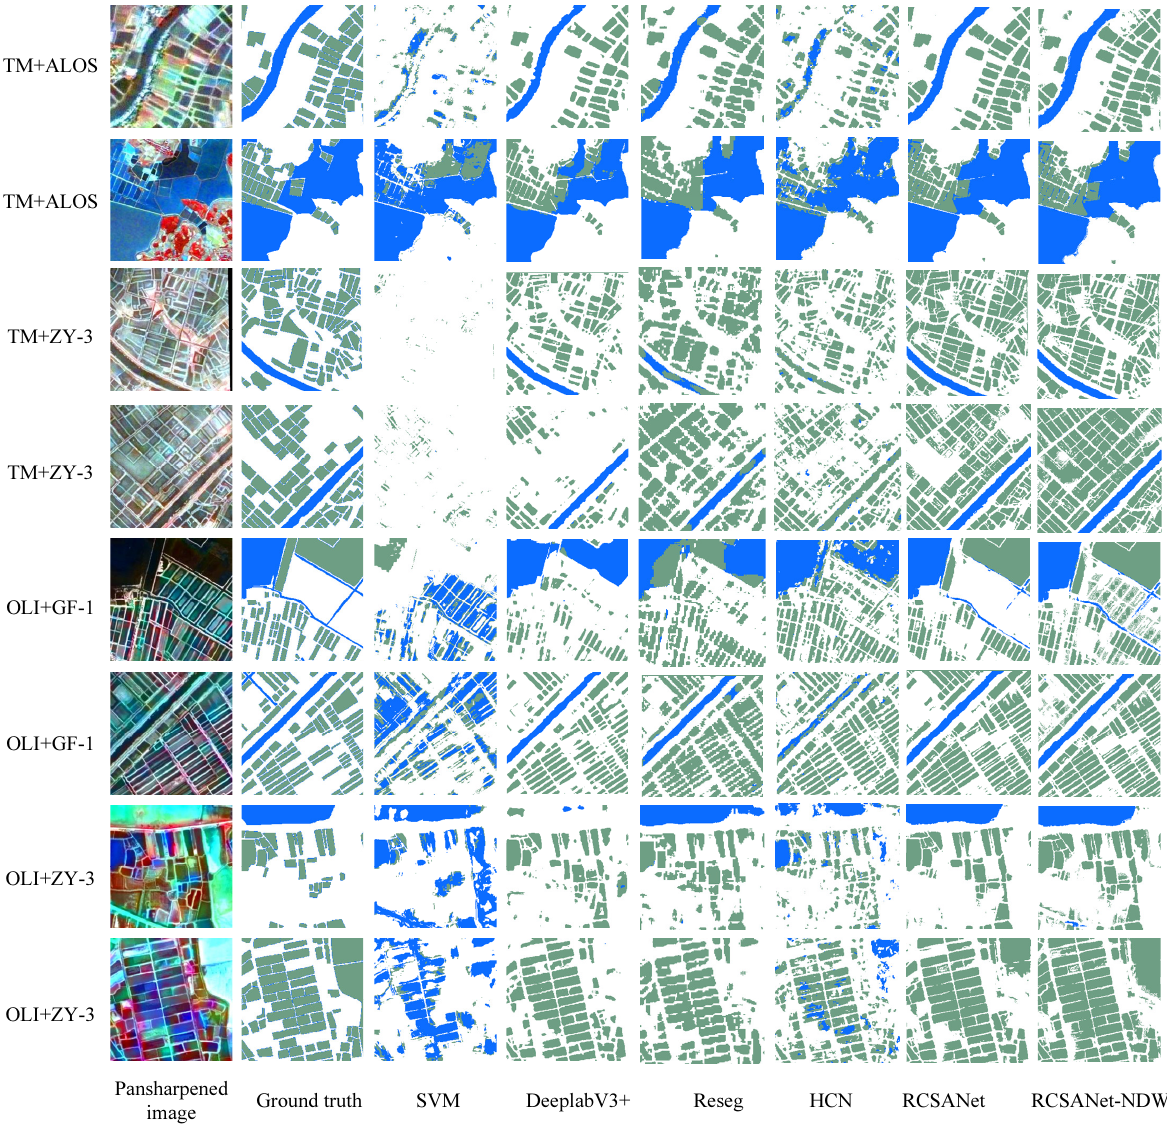
Figure 7. Semantic segmentation results for 256 × 256 pixel image patches from test set in Part 1 of the experiment. The leftmost column gives the sensors or satellites to which the multispectral and panchromatic data of the pansharpened images belong, and the bottom row lists the different methods by which the semantic segmentation images in the same column were